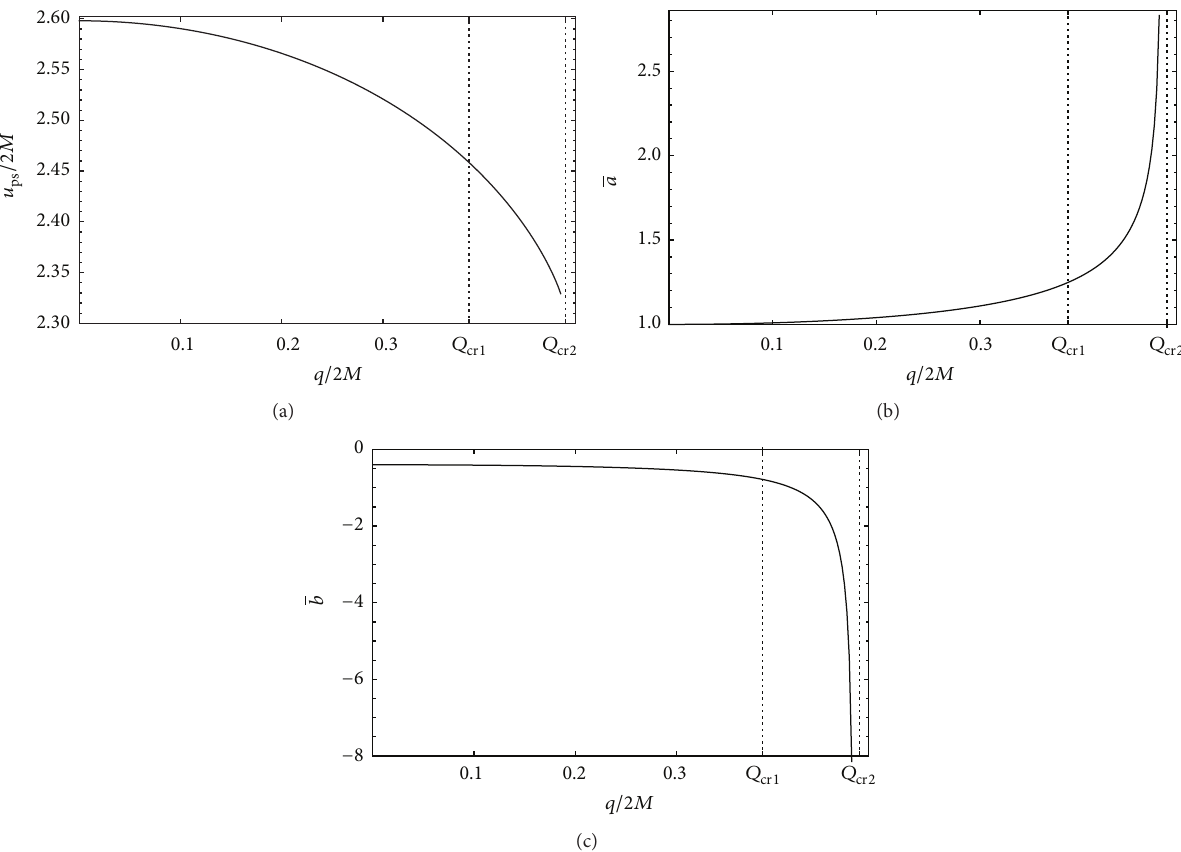
Figure 3: Behaviors of the minimal impact parameter 𝑢